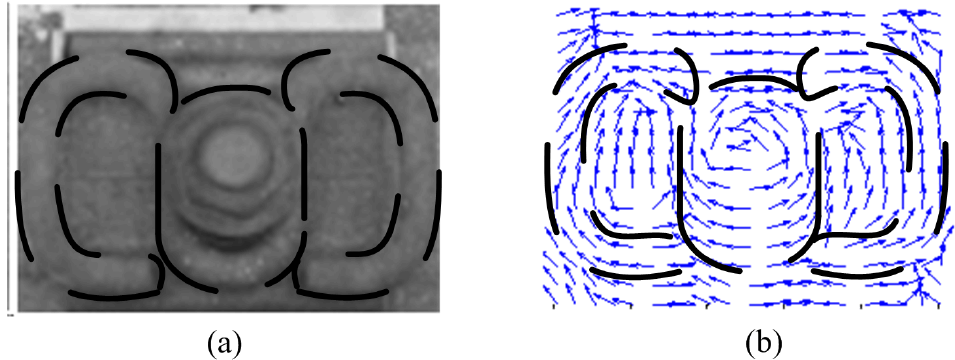
Figure 7. Image of the fastener ( a ) and its DF ( b